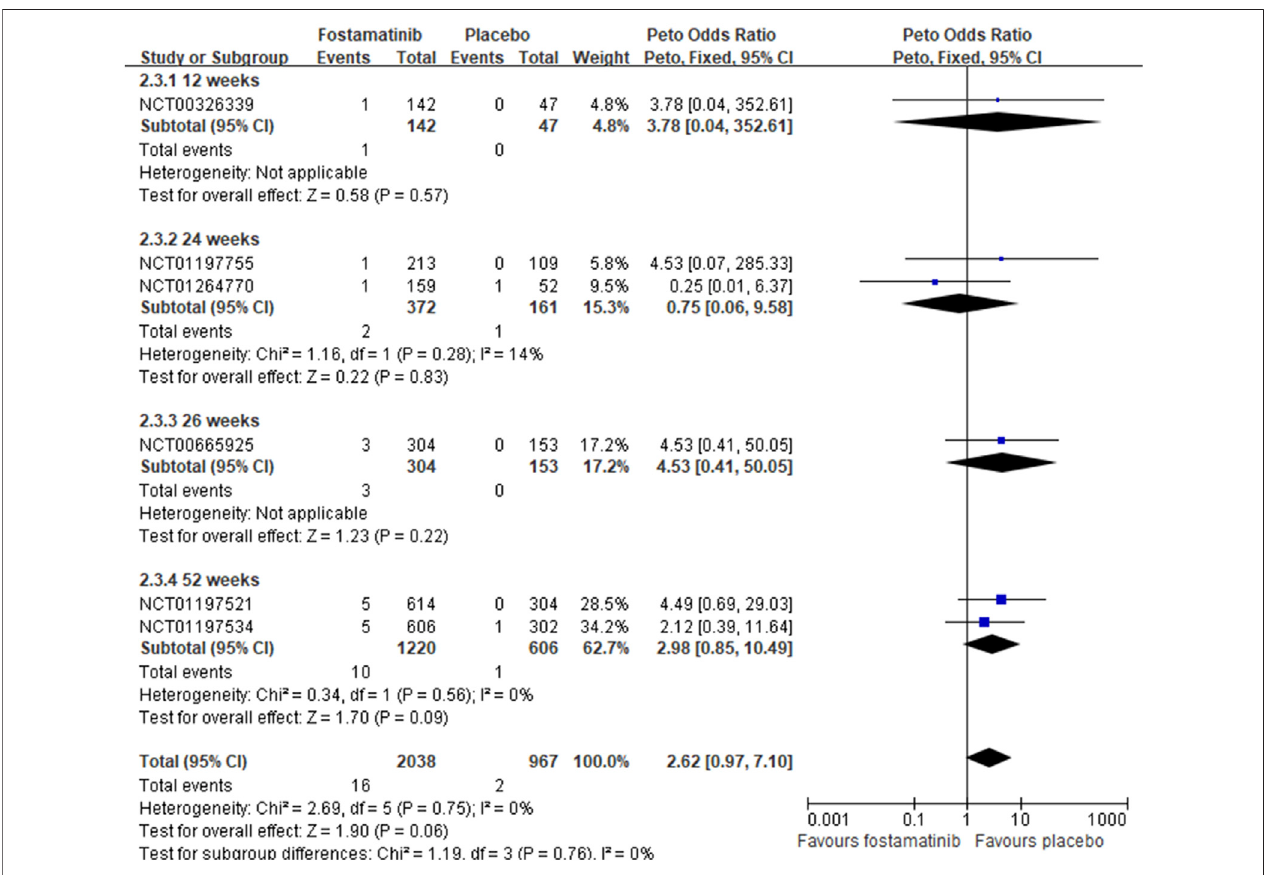
FIGURE 5 | Forest plot of overall neoplasms based on fostamatinib versus